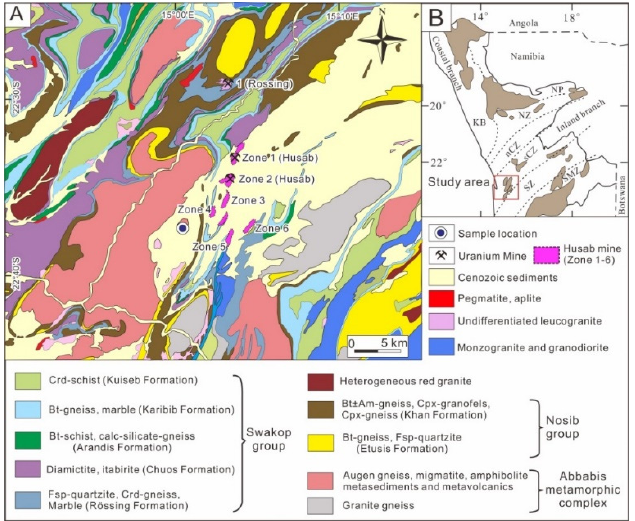
Figure 1. ( A ) Regional map showing distribution of various domes, the Abbabis Metamorphic Complex spatially associated with primary uranium deposits of the Central Zone. ( B ) Geological framework of the Damara orogen showing the study area within the Central Zone, Namibia. Abbre- viations in inset: KB: Kaoko Belt, NP: Northern Platform, NZ: Northern Zone, nCZ: Northern Central Zone, sCZ: Southern Central Zone, SZ: Southern Zone, SMZ: Southern Marginal Zone